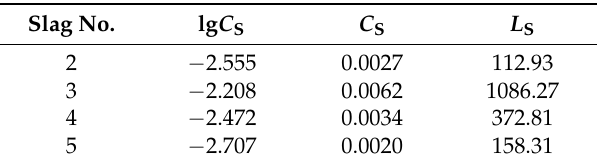
Table 10. Calculation results of the sulfur capacity and the equilibrium distribution ratio of sulfur between slag and molten steel at 1600 ◦ C.